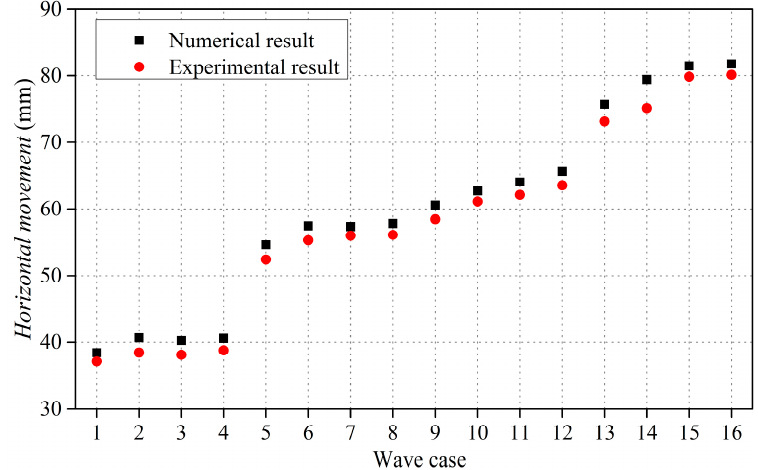
Figure 9. The comparison of horizontal movement of the net between the numerical and experiment results.